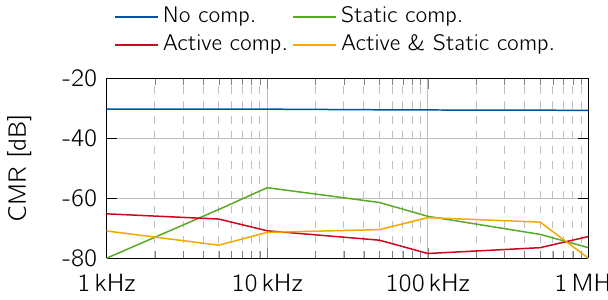
Figure 14: CMR of the VS: The static compensation (green) has a performance loss between 10 kHz and 100 kHz, where active compensation (red) and combined compensation (yellow) achieve a more constant CMR over the whole frequency